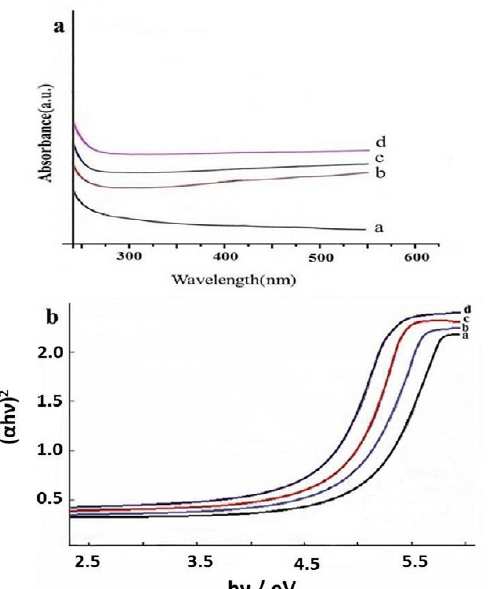
O (a), diatom coated with 4% Dy-doped Y 2 3 Y O (c) and diatom coated with 8%Dy-doped Y Figure 4. (a) Absorbance spectra and ( b ) Tauc plot of diatom coated with Y 2 O 3 (a), diatom 2 3 coated with 4%Dy-doped Y 2 O 3 (b), diatom coated with 6%Dy-doped Y 2 O 3 (c), diatom coated with 8%Dy-doped Y 2 O 3 (d) at room temperature